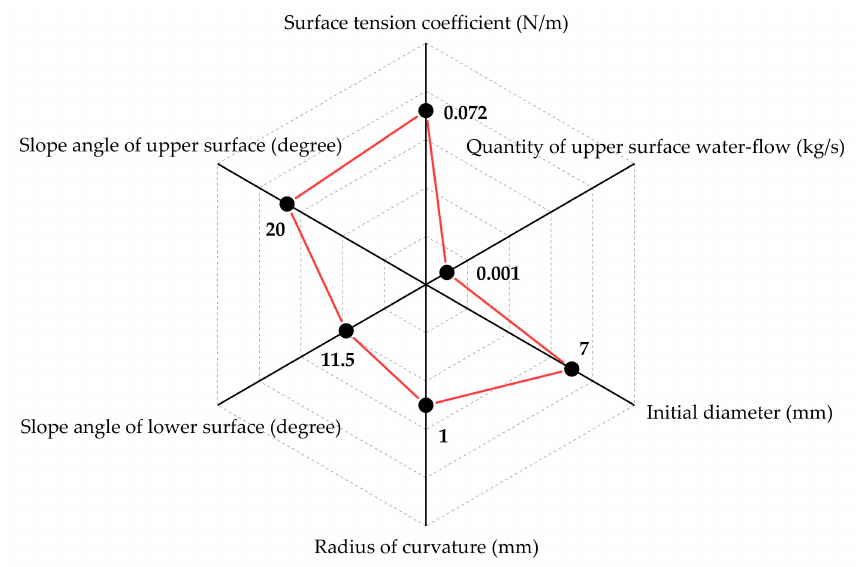
Figure 13. Parameter selection of the simulation